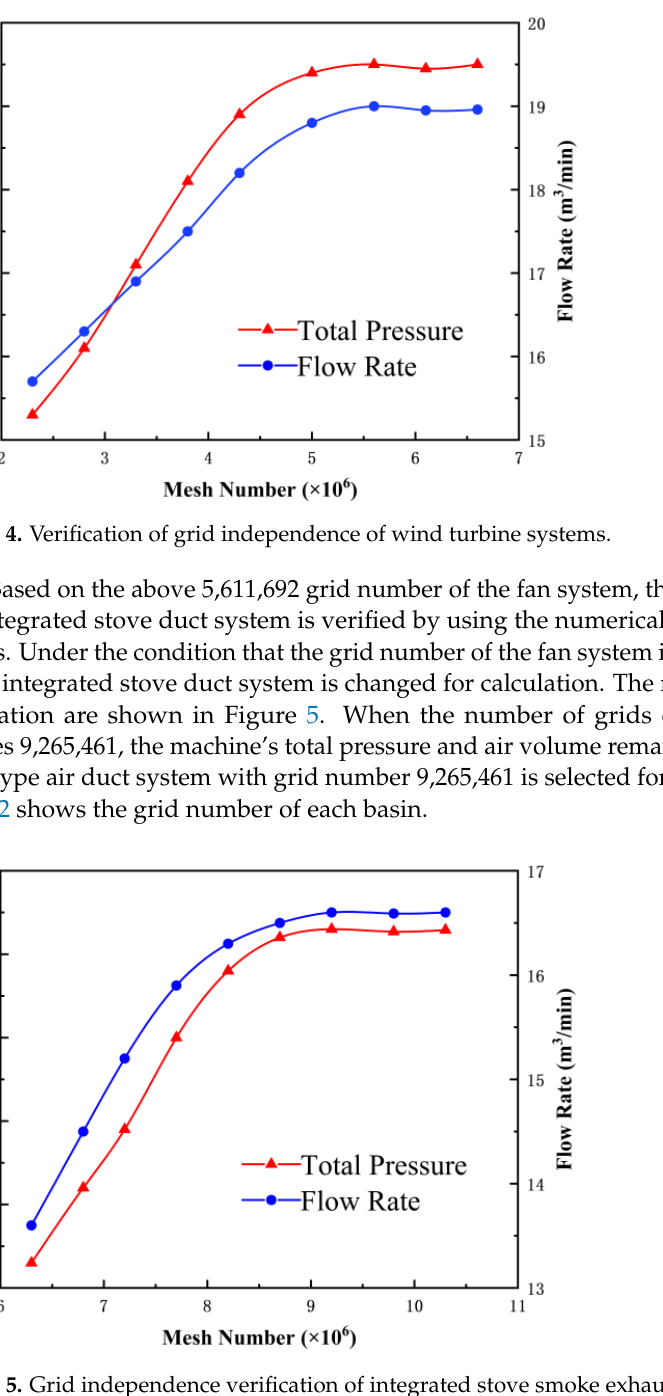
Figure 5. Grid independence verification of integrated stove smoke exhaust system. Table 2. Number of grids in each fluid domain.